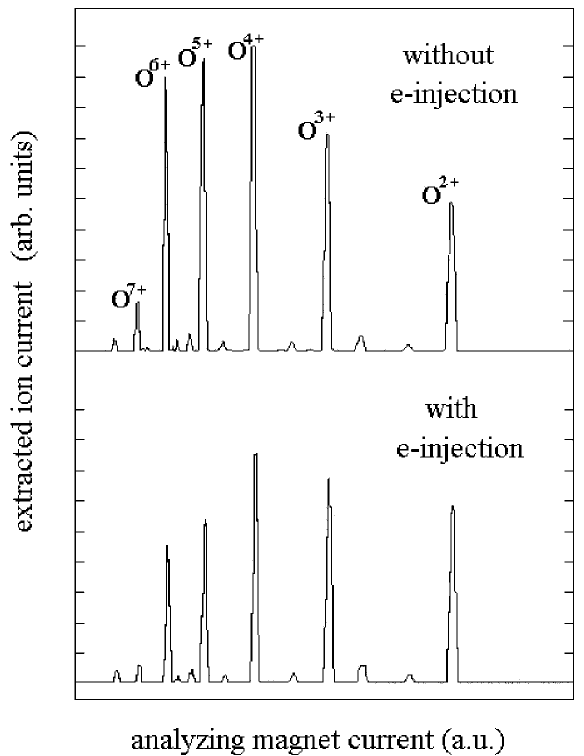
FIG. 2. The two frames show the charge state distribution before and after the electron injection: The reduction of the highly charged ions and the enhancement of the lowly charged ones is